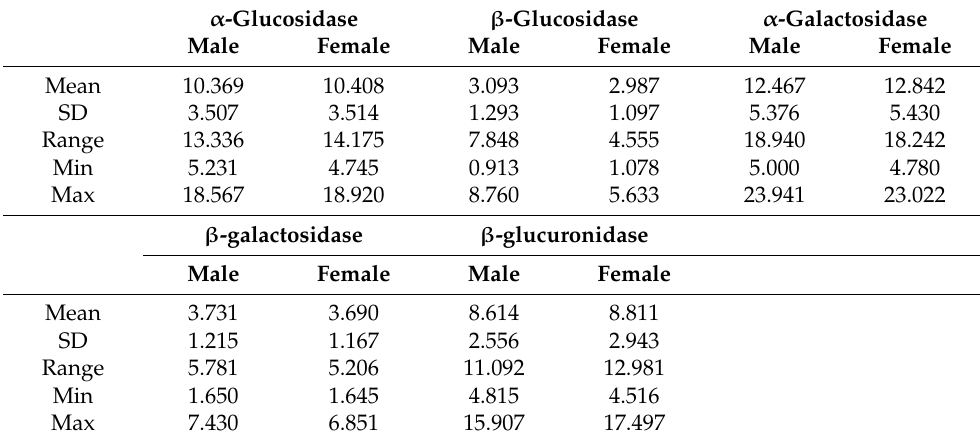
Table 5. Comparison of activities of fecal enzymes in the group of males versus females. α -Glucosidase β -Glucosidase α -Galactosidase Male Female Male Female Male Female Mean 10.369 10.408